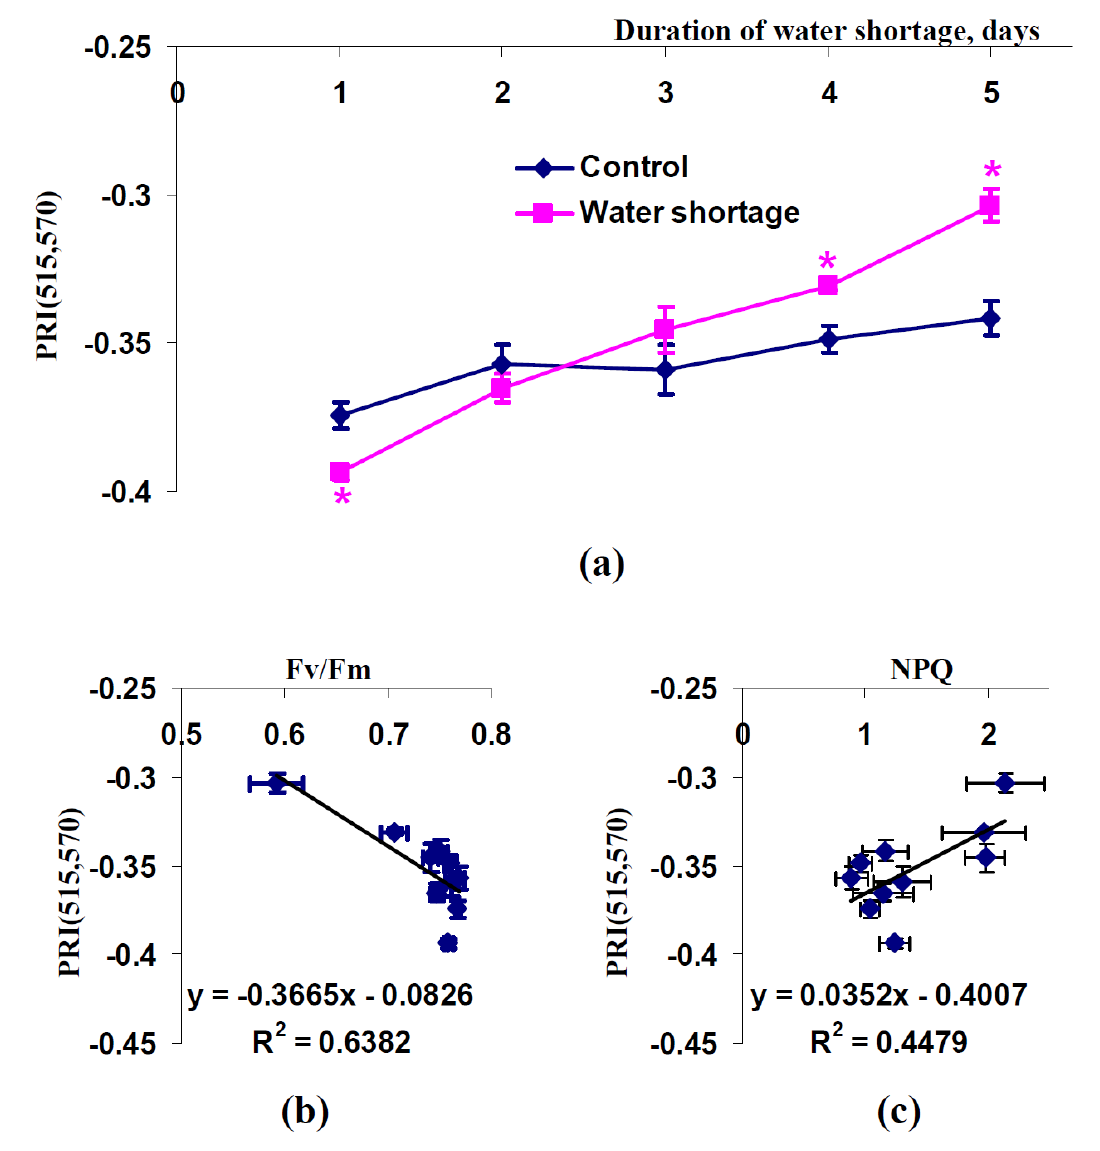
Figure 3. Dependence of the modified photochemical reflectance index calculated on the basis of 515 and 570 nm wavelengths (PRI(515,570)) in spatially-fixed leaves of pea plants on duration of water shortage ( n = 5–6) ( a ) and dependences of average values of PRI(515,570) on Fv/Fm ( b ) and NPQ ( c ) ( n = 10). Average values of Fv/Fm and NPQ from Figure 2 were used. R 2 is the determination coefficient. *, difference between experimental and control indices was significant ( p < 0.05).